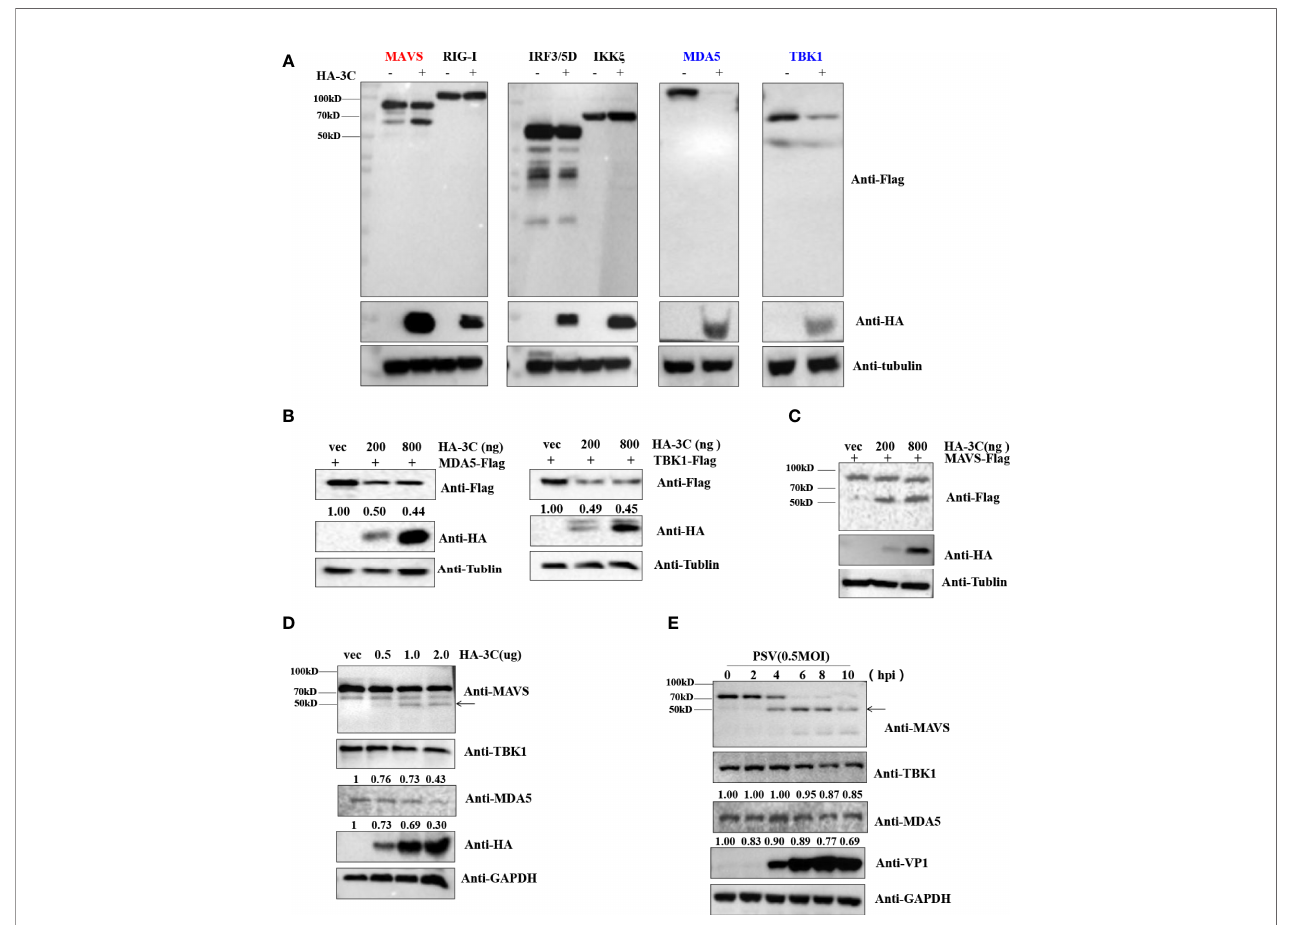
FIGURE 4 | PSV 3C pro inhibits IFN- b activation by downregulation of MDA5/TBK1 and cleavage of MAVS. (A) HEK293T cells were seeded in 24-well plates, and the monolayer cells were co-transfected with 300 ng indicated adaptor-expressing plasmids and 300 ng of empty vector or a plasmid encoding HA-3C for 24 h. The cells were collected for Western blotting. (B,C) HEK293T cells were co-transfected with different doses of HA-3C (0 ng, 200 ng, 800 ng), and 500 ng indicated adaptor-expressing plasmids. The cells were collected for Western blotting. (D) HEK293T cells were transfected with different doses of HA-3C (0.5 m g, 1 m g, 2 m g) for 24 h. The cells were collected for Western blotting. (E) HEK293T cells were infected with 0.5 MOI PSV for the indicated times, and then the cells were collected for Western blotting. Data are represented as means ±